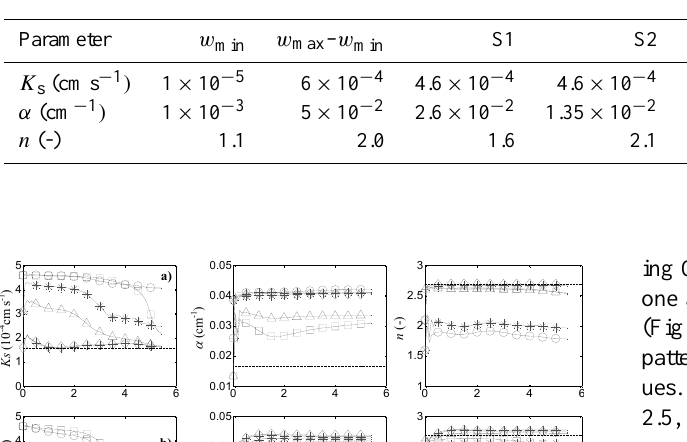
Table 3. Values of w min and w max – w min used to constrain the distribution of the parameters K s , α and n , and the resulting six sets of parameter values employed for initializing the assimilation algorithm.